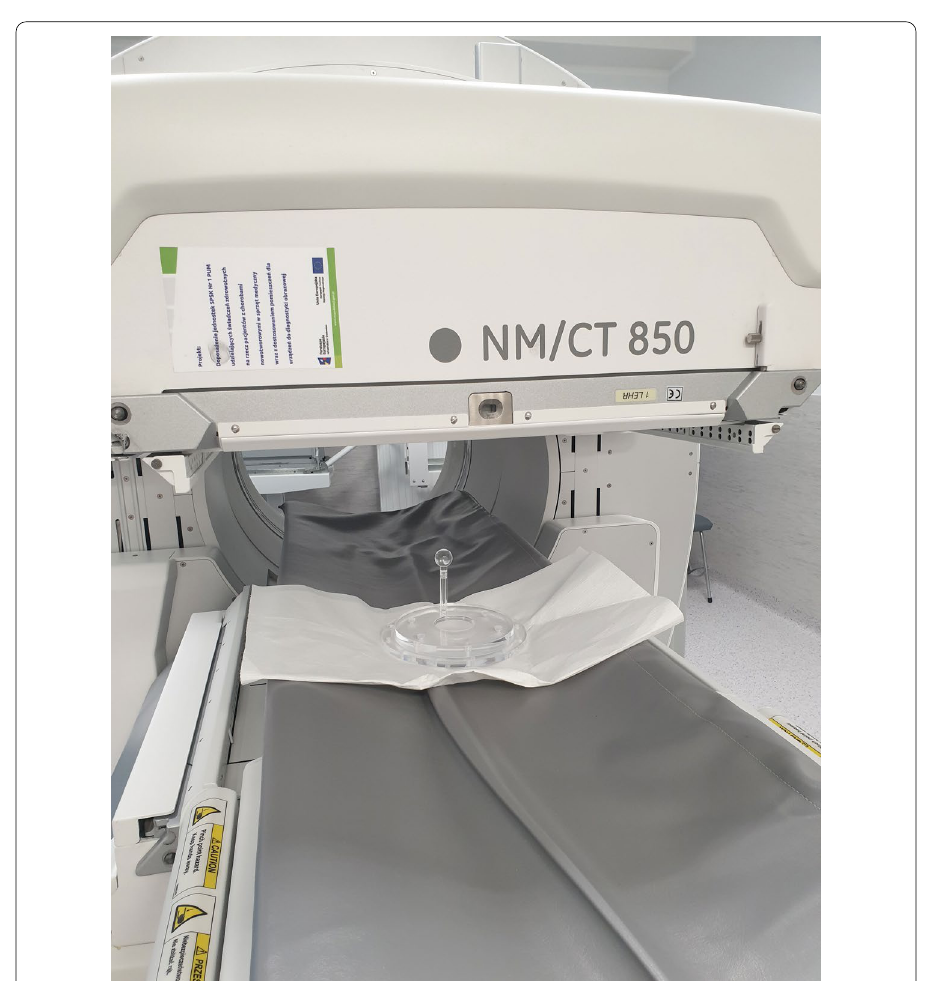
Fig. 3 Acquisition of the calibration source in Department